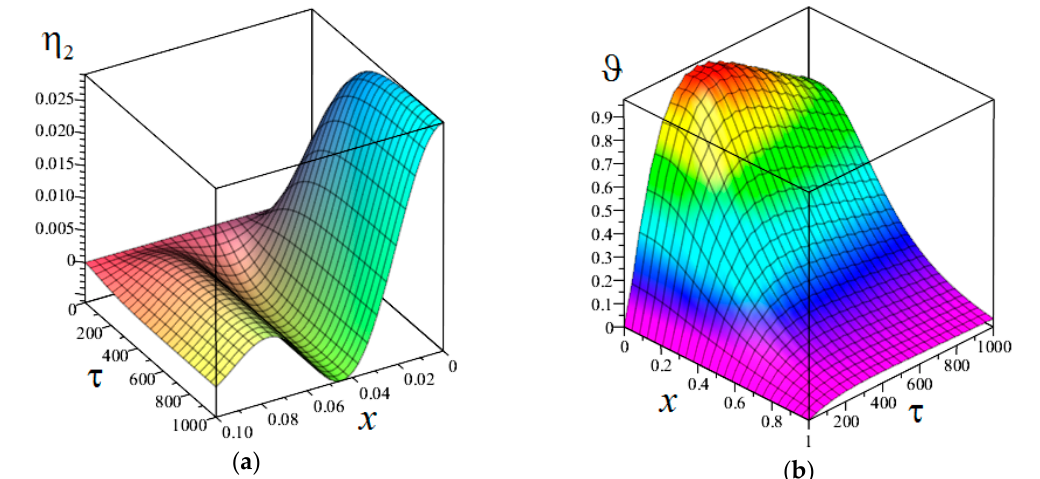
η ; and ( b ) temperature increment ϑ . Figure 6. ( a ) Concentration increment η 2 ; and ( b ) temperature increment 2